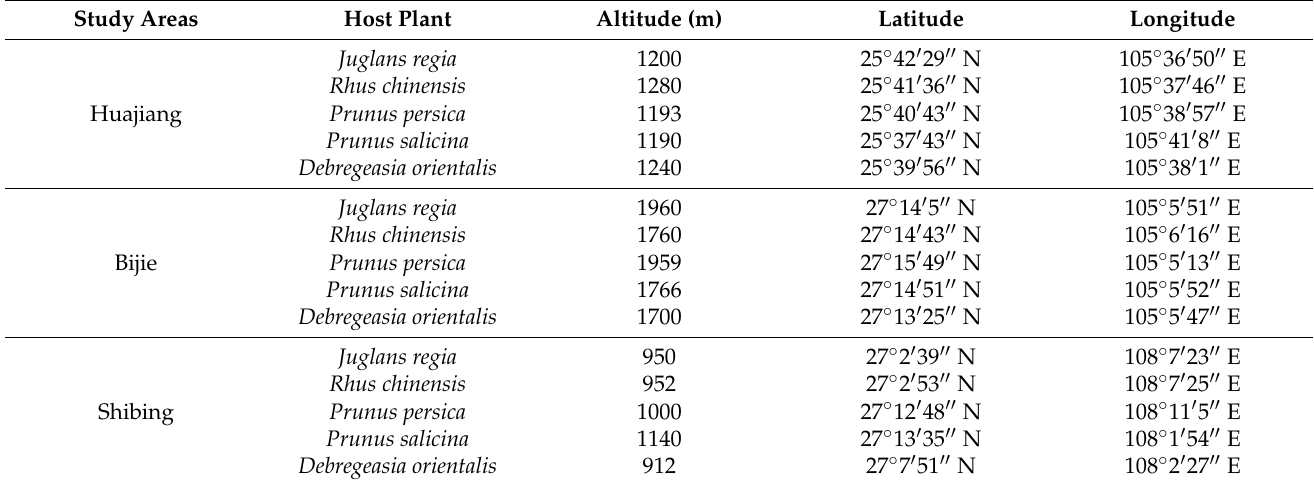
Table 1. Overview of the sample